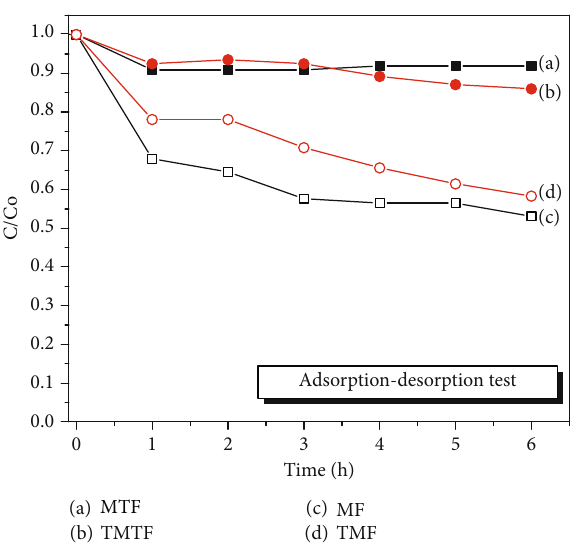
Figure 9: Photocatalytic test between Rh B solution in the presence of di ff erent photocatalyst. The test was carried out under Vis-IR